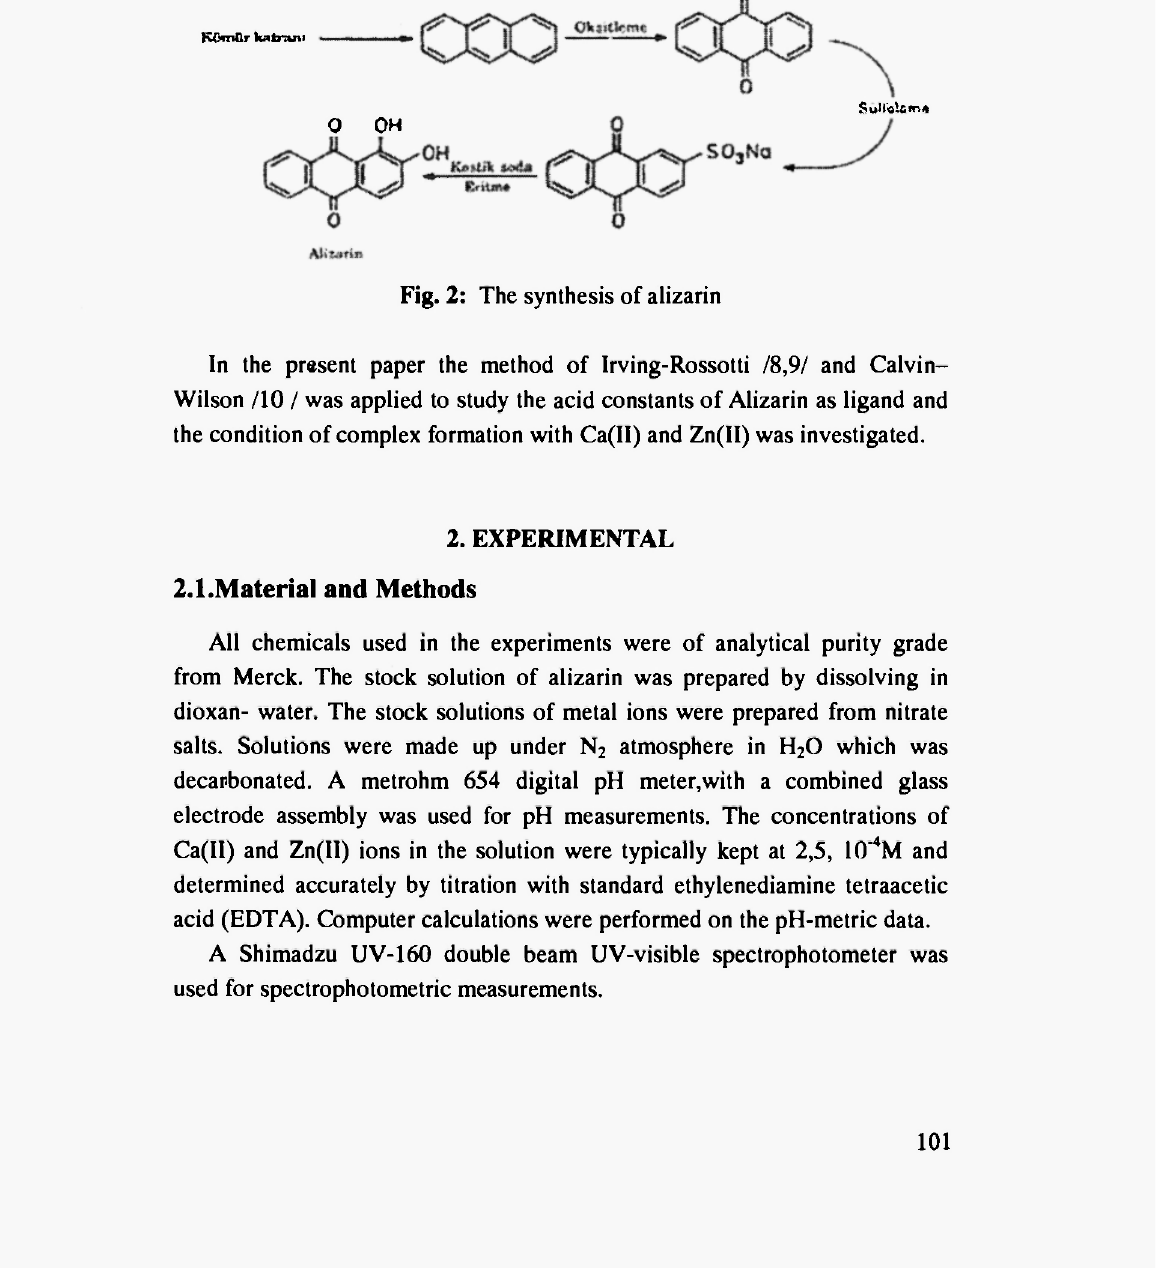
Fig. 2: The synthesis of